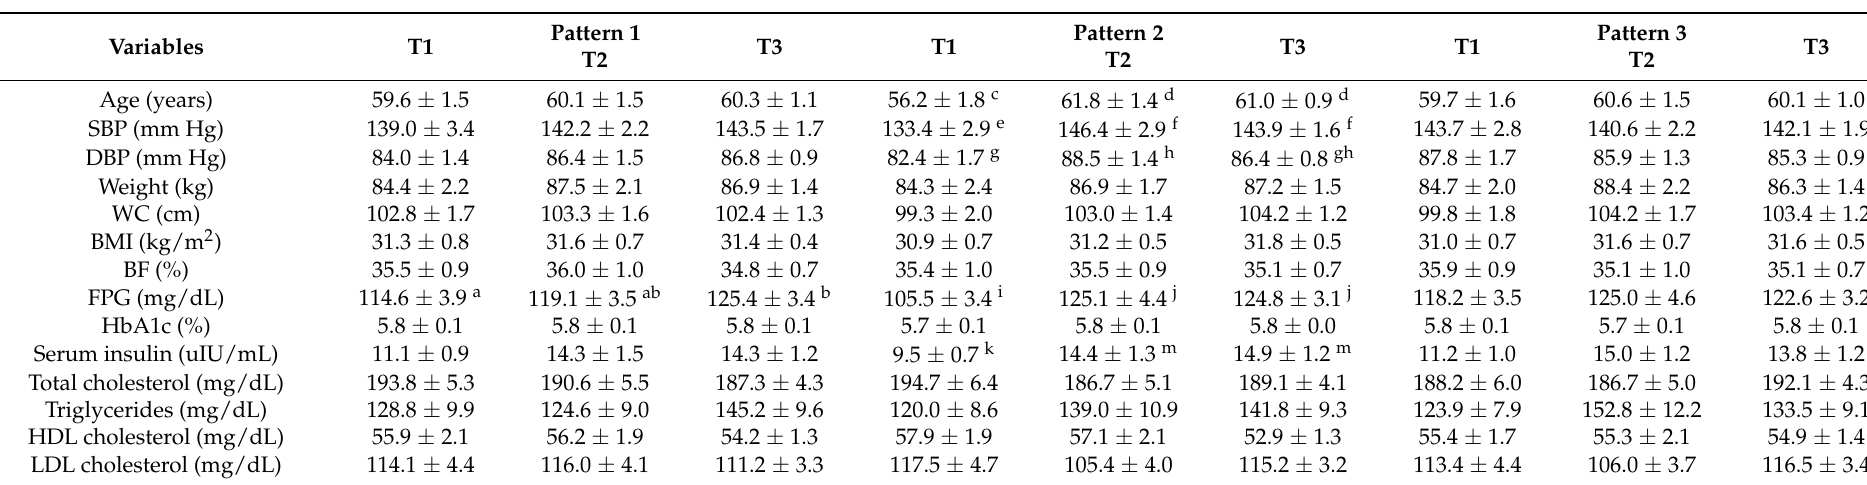
Table 4. General characteristics, anthropometric measurements and biomarkers of prediabetic patients across tertiles of dietary